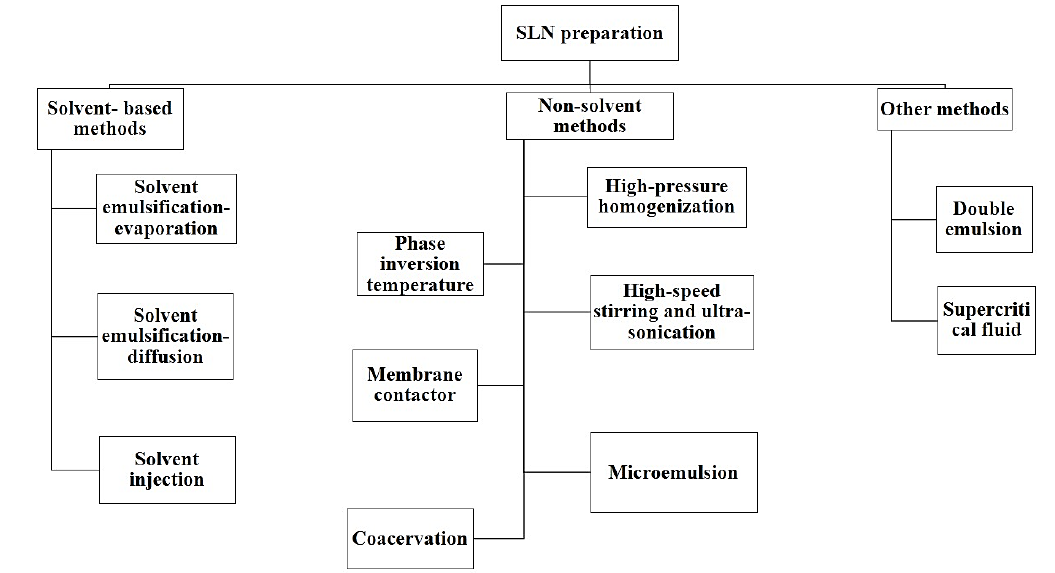
Fig. 3: Classification of SLN preparation methods